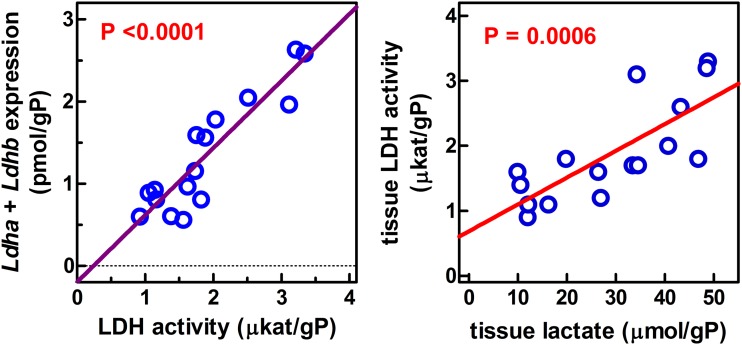
Linear correlation analysis of the relationship between lactate dehydrogenase activity and expression or tissue lactate content in WAT sites of male and female rats fed a control or cafeteria diet.LDH = lactate dehydrogenase; gP = g of protein. Each circle represents the mean value for one group of rats (i.e. female/male, control/cafeteria). Enzyme activities are those presented in Fig. 3; expression data are the sum of Ldha and Ldhb (Fig. 2) for the corresponding groups; tissue lactate were those shown in Table 4. Correlation between lactate dehydrogenase activity and gene expression: r2 = 0.828, significantly different from zero (P<0.0001). When all the individual data (i.e. all sites and groups) were plotted, the corresponding values were r2 = 0.380, and P<0.0001. The separate analyses of Ldha and Ldhb (using the mean values) gave similar results Ldha r2 = 0.642, P = 0.0002, and Ldhb r2 = 0.840, P<0.0001. Correlation between tissue lactate dehydrogenase activity and lactate content: r2 = 0.583, significantly different from zero (P = 0.0006). When all the individual data (i.e. all sites and groups) were plotted instead of only the means, the corresponding values were r2 = 0.307, and P<0.0001.